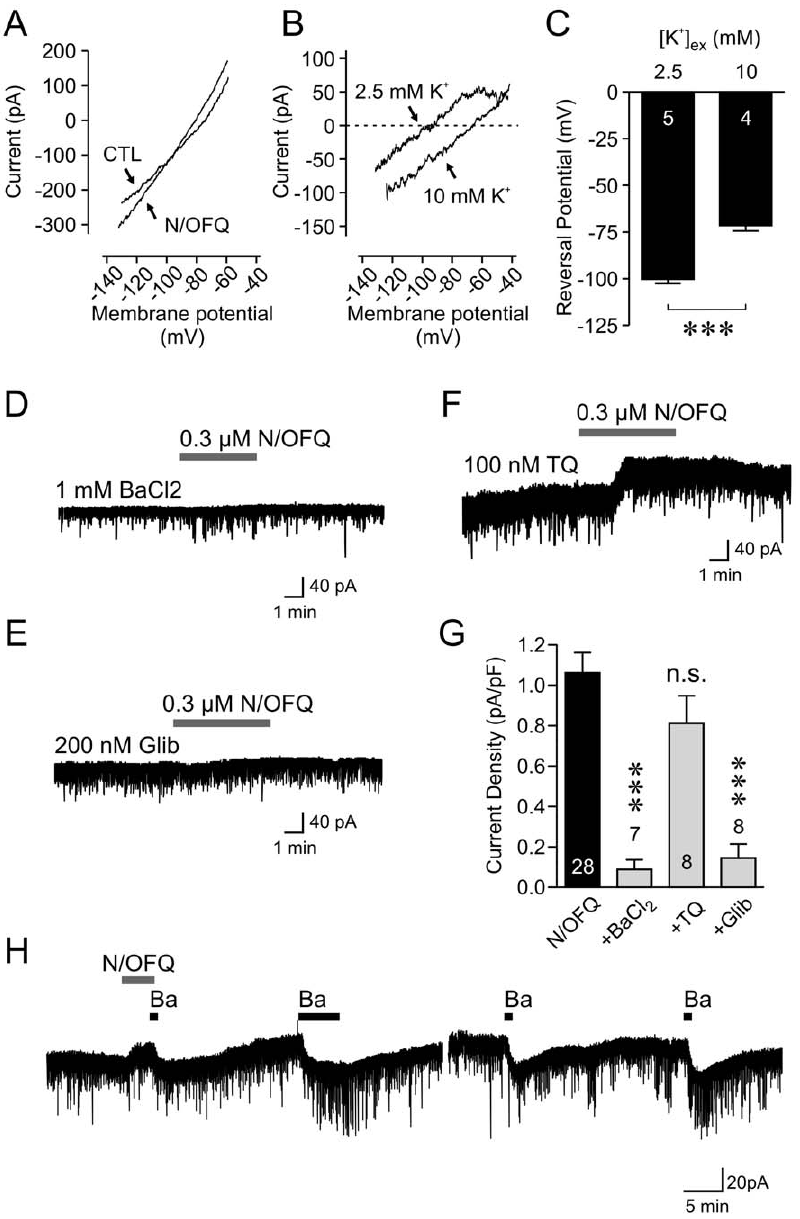
Figure 3. N/OFQ activates KATP channels in orexin neurons. A : Current responses to voltage-ramps before (control; CTL) and during N/OFQ application in 2.5 mM extracellular potassium. B: Subtraction of currents recorded in two conditions (N/OFQ - CTL) reveals an N/OFQ-induced current (2.5 mM K + ). Increasing the extracellular potassium concentration to 10 mM shifted the current-voltage relationship rightward. C . Grouped data showing that the reversal potential of the N/OFQ current is dependent on the concentration of extracellular potassium. *** p , 0.005. D-F : N/OFQ responses are attenuated by BaCl 2 ( D ) and glibenclamide (Glib) ( E ) but not tertiapin Q (TQ) ( F ). Grouped data are shown in (G). *** p , 0.005, n.s. non- significant vs. N/OFQ. Numbers in bars represent the number of cells examined in each group. H : Once N/OFQ current is induced, it is persistent and retains Ba ++ sensitivity even after a prolonged washout. test) but not naloxone, the antagonist for the classic opioid receptors (10 m M; Fig. 2E, n= 4, p . 0.05, Dunnett’s test). The N/ OFQ current was also significantly attenuated by postsynaptic loading of the non-hydrolysable GDP analogue GDP b S (2 mM; Fig. 2D, E, n = 6, p , 0.005, Dunnett’s test). These results suggest that N/OFQ directly activates G-protein coupled NOP receptors on orexin neurons. 2 66.3 mV (n =4, Fig. 3A–C, p , 0.0001 vs. standard ACSF,